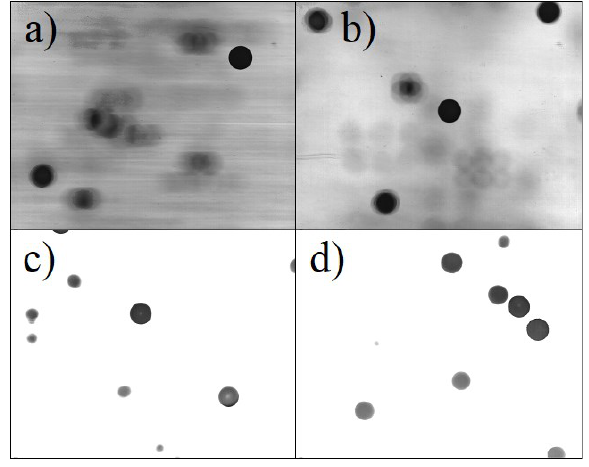
Fig. 8. The capture image for shutter speed 10  s: a) 1000 W Halogen lamp; b) 72 W LED bar panel; c) 60 W LED chip; d) 90 W LED chip.